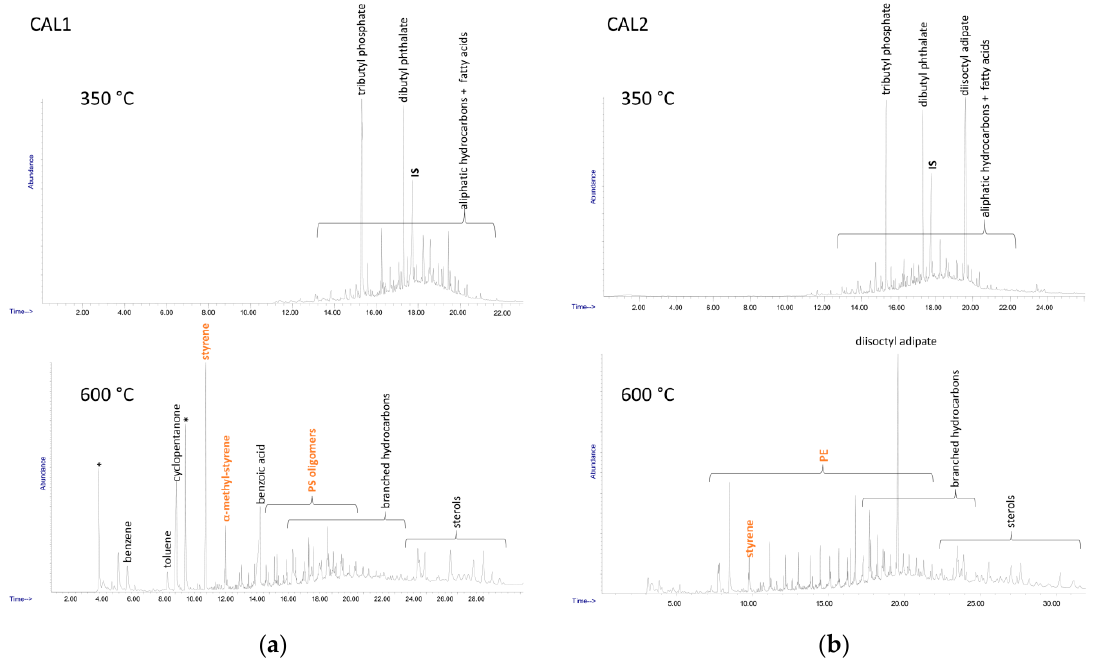
Figure 7. Py-GC-MS chromatograms of sediment DCM extracts: ( a ) CAL1; ( b ) CAL2. The Py-GC/MS chromatogram obtained at 350 °C from the MEL1 extract was mainly characterized by the presence of tributyl phosphate (TBP) and dibutyl phthalate (DBP),